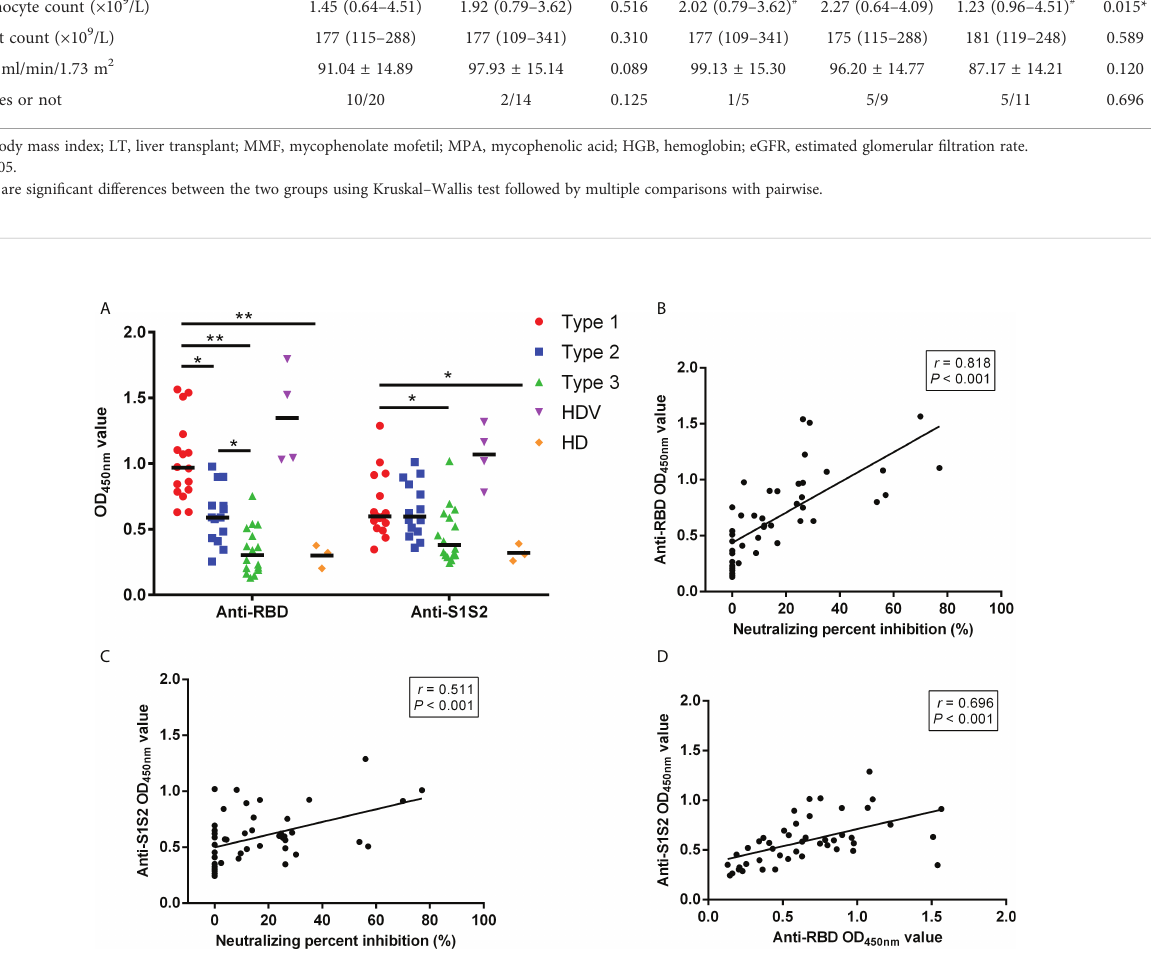
FIGURE 2 Comparison of antibody responses between different groups. (A) Comparison of anti-RBD and anti-S1S2 antibody responses among the Type 1, Type 2, and Type 3 groups. Correlation between anti-RBD and anti-S1S2 levels. (B) NPI and anti-RBD levels. (C) NPI and anti-S1S2 levels. (D) p - Values (two-sided) and r values are based on Spearman ’ s rank test. NPI, neutralizing percent inhibition. *p < 0.05, **p < 0.01.